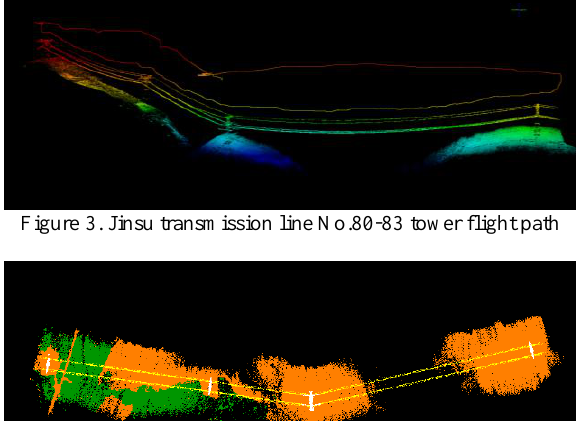
Figure 7. Pole extraction